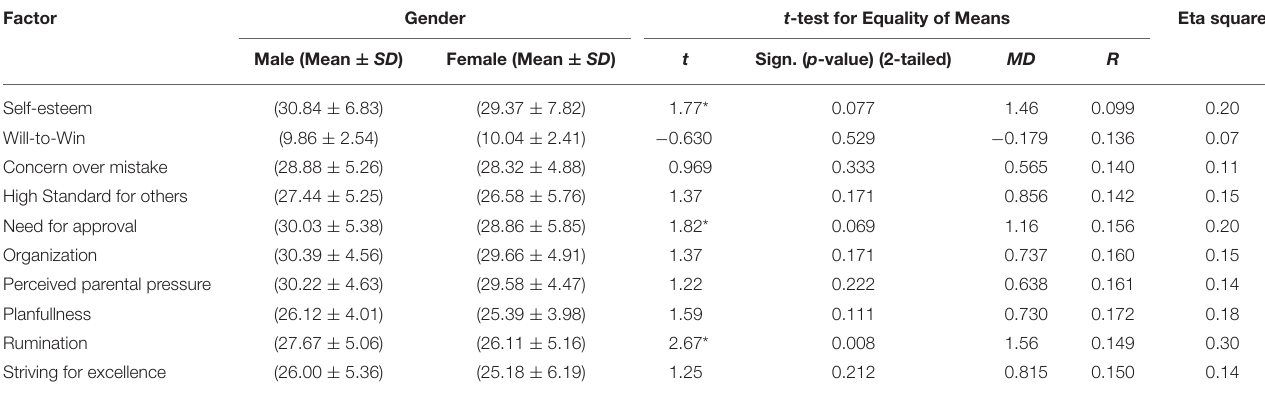
TABLE 3 | Gender-based descriptive statistics and differences on the variables using independent t